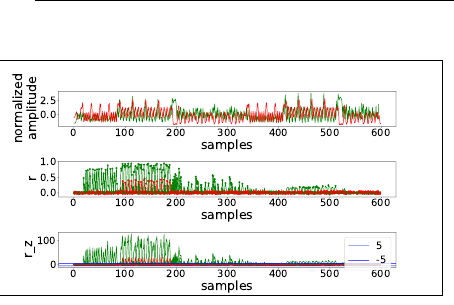
(a) Screaming Cable (red) vs. Conventional, ρ -test (b) Screaming at 10cm (red) vs. Conventional, ρ -test Figure 4: Results of the ρ -test (average trace, correlation, confidence). Comparison between screaming-channel via cable and conventional (a), and between screaming-channel at 10 cm and conventional (b). Correlation peaks and number of POIs are higher for the conventional